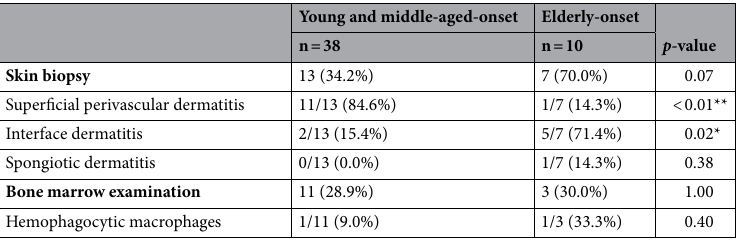
Table 3. Comparison of the pathological findings of the skin biopsy and bone marrow of the young and middle-aged-onset and elderly-onset groups. Data represent the number of patients. p -value: Fisher exact test for categorical variables. *Significant value ( p < 0.05). **Significant value ( p < 0.01).